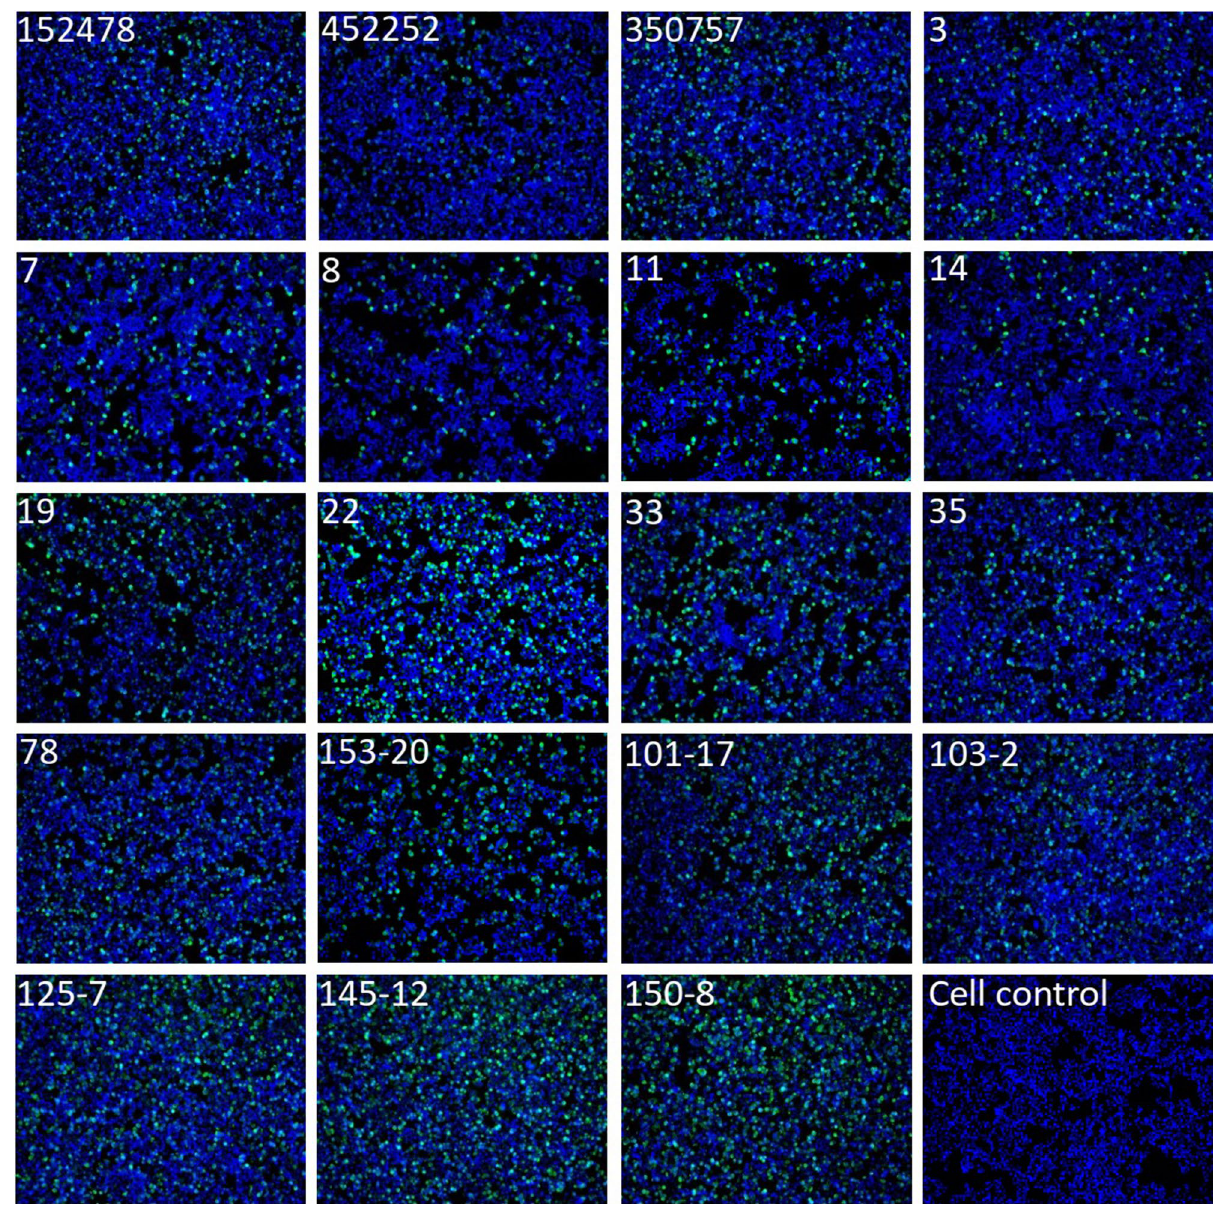
Figure 3. Detection of PeV-A1-infected HT-29 cells with scFv-71. HT-29 cells were mock-inoculated or inoculated with 19 clinical PeV-A1 isolates followed by staining with scFv-71 antibody and rabbit